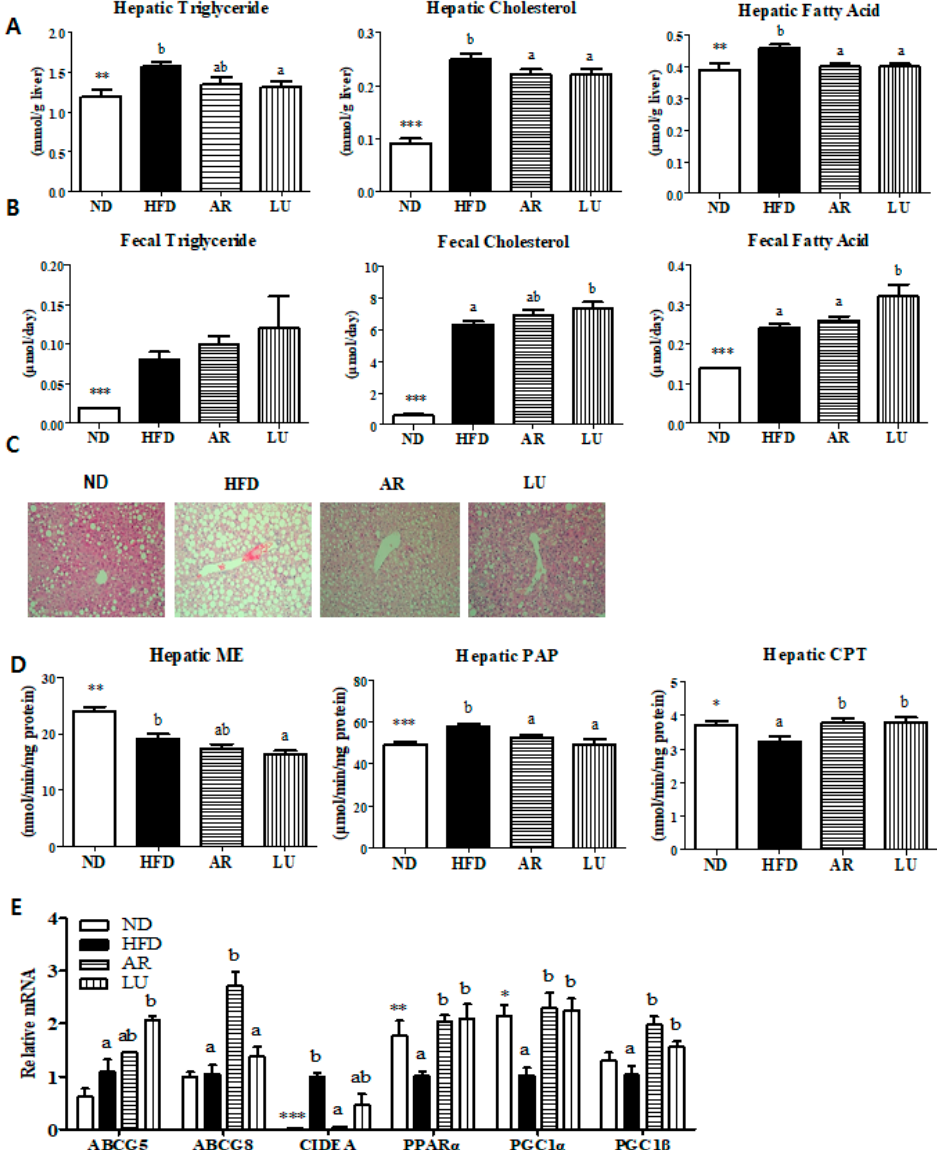
Figure 2. Effects of luteolin-enriched artichoke extract and luteolin on the hepatic lipid levels ( A ), fecal lipid levels ( B ), hepatic morphology (magnification 200 × ) ( C ), hepatic lipid-regulating enzyme activities ( D ), and hepatic gene expression ( E ) in C57BL/6N mice fed a high-fat diet. Data are the mean ± SEM. Significant differences between the HFD and ND groups are indicated: * p < 0.05, ** p < 0.01, *** p < 0.001. Bars marked with different lower case letters indicate significant differences among the groups based on the HFD (HFD, AR, and LU) at p < 0.05. Bars marked with the same lower case letters indicate no significant differences among the groups based on the HFD. ND, normal diet (AIN-76), HFD, high-fat diet (20% fat, 1% cholesterol), AR, HFD + 0.005% luteolin-enriched artichoke, LU, HFD + 0.005% luteolin, ME, malic enzyme, PAP, phosphatidate phosphohydrolase, CPT, carnitine palmitoyltransferase.